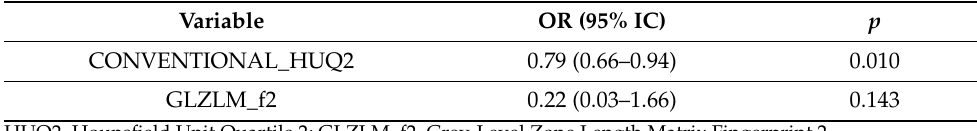
Table 5. Multivariate analysis of predictors of NASH.